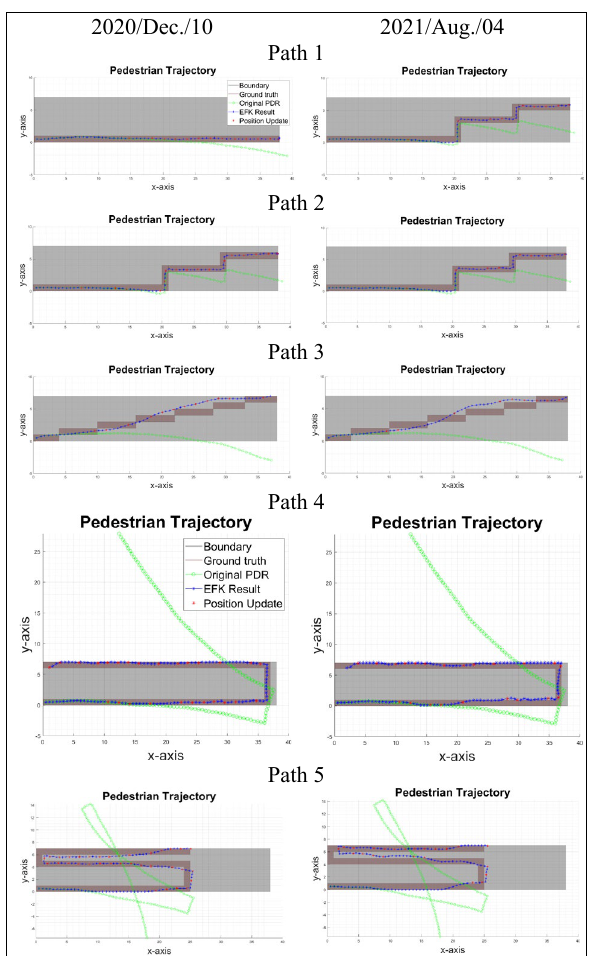
Figure 14. The online test with 5 different